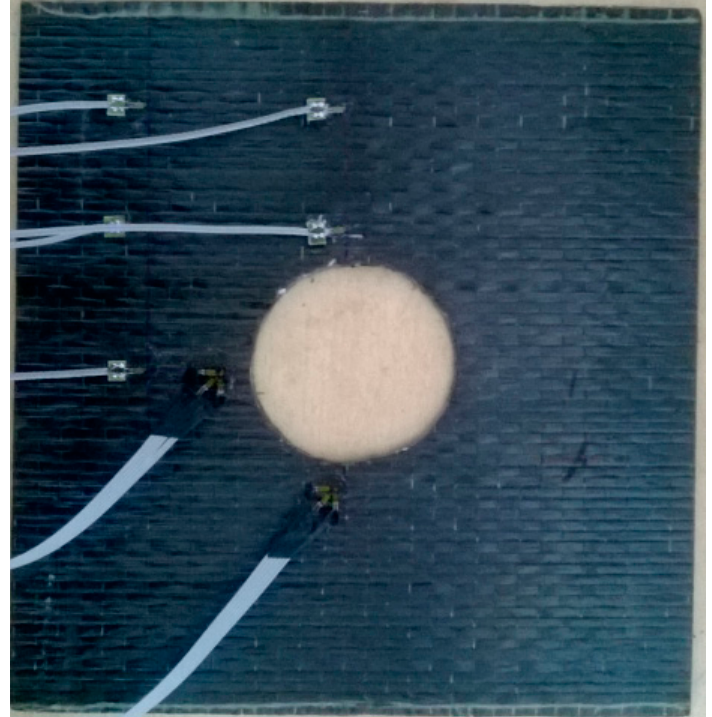
Figure 7. A classic perforated plate strengthened with FRP. Table 1. The basic geometry and material parameters. BCs: Boundary conditions.